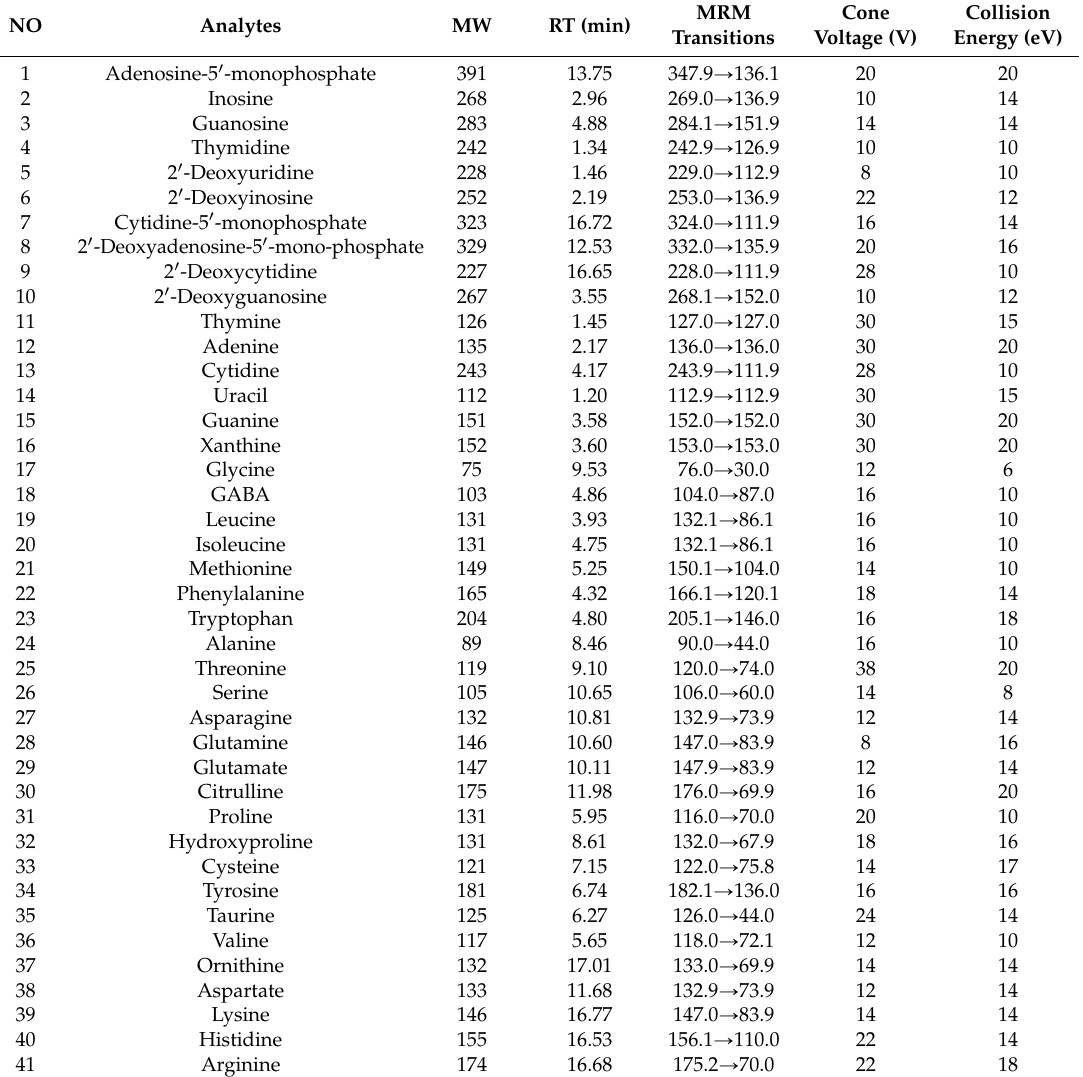
Table 1. Precursor/product ion pairs and parameters for MRM of compounds used in this